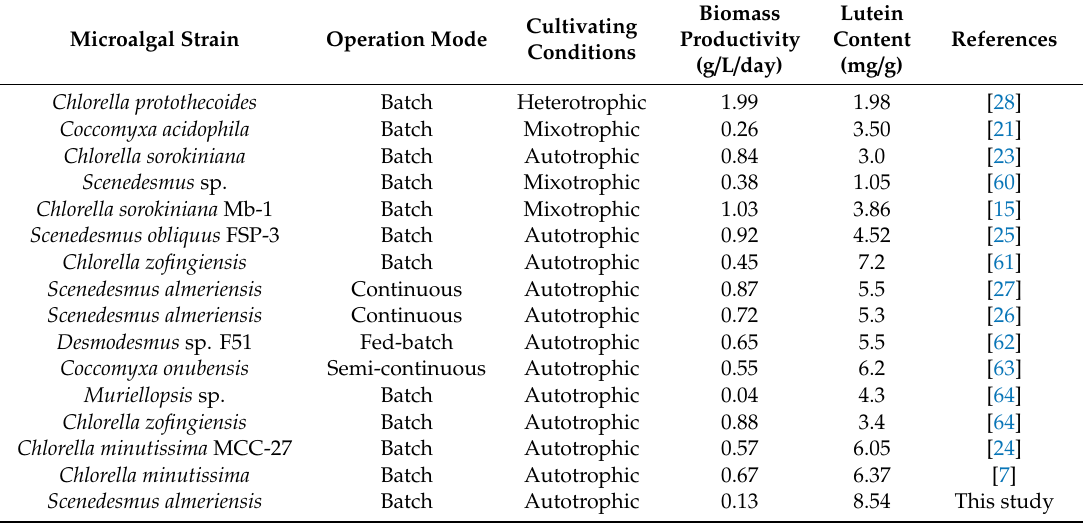
Table 3. Biomass productivity and lutein content